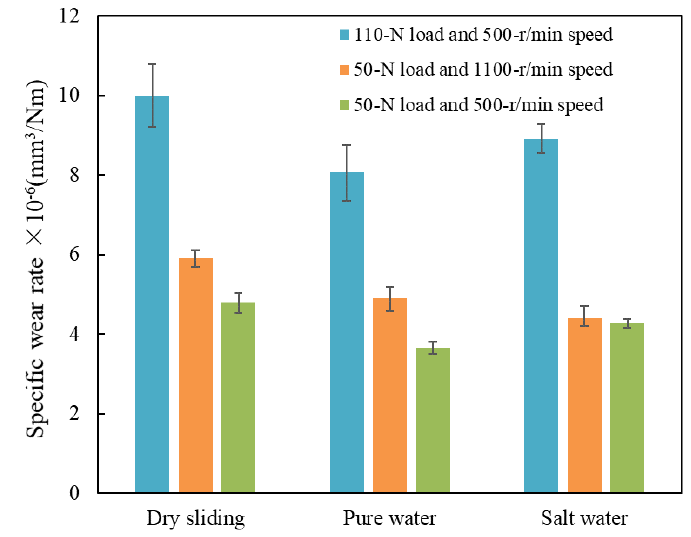
Figure 12. Specific wear rates of UHMWPE under dry sliding, water lubrication and saltwater lubrication at different sliding variables.